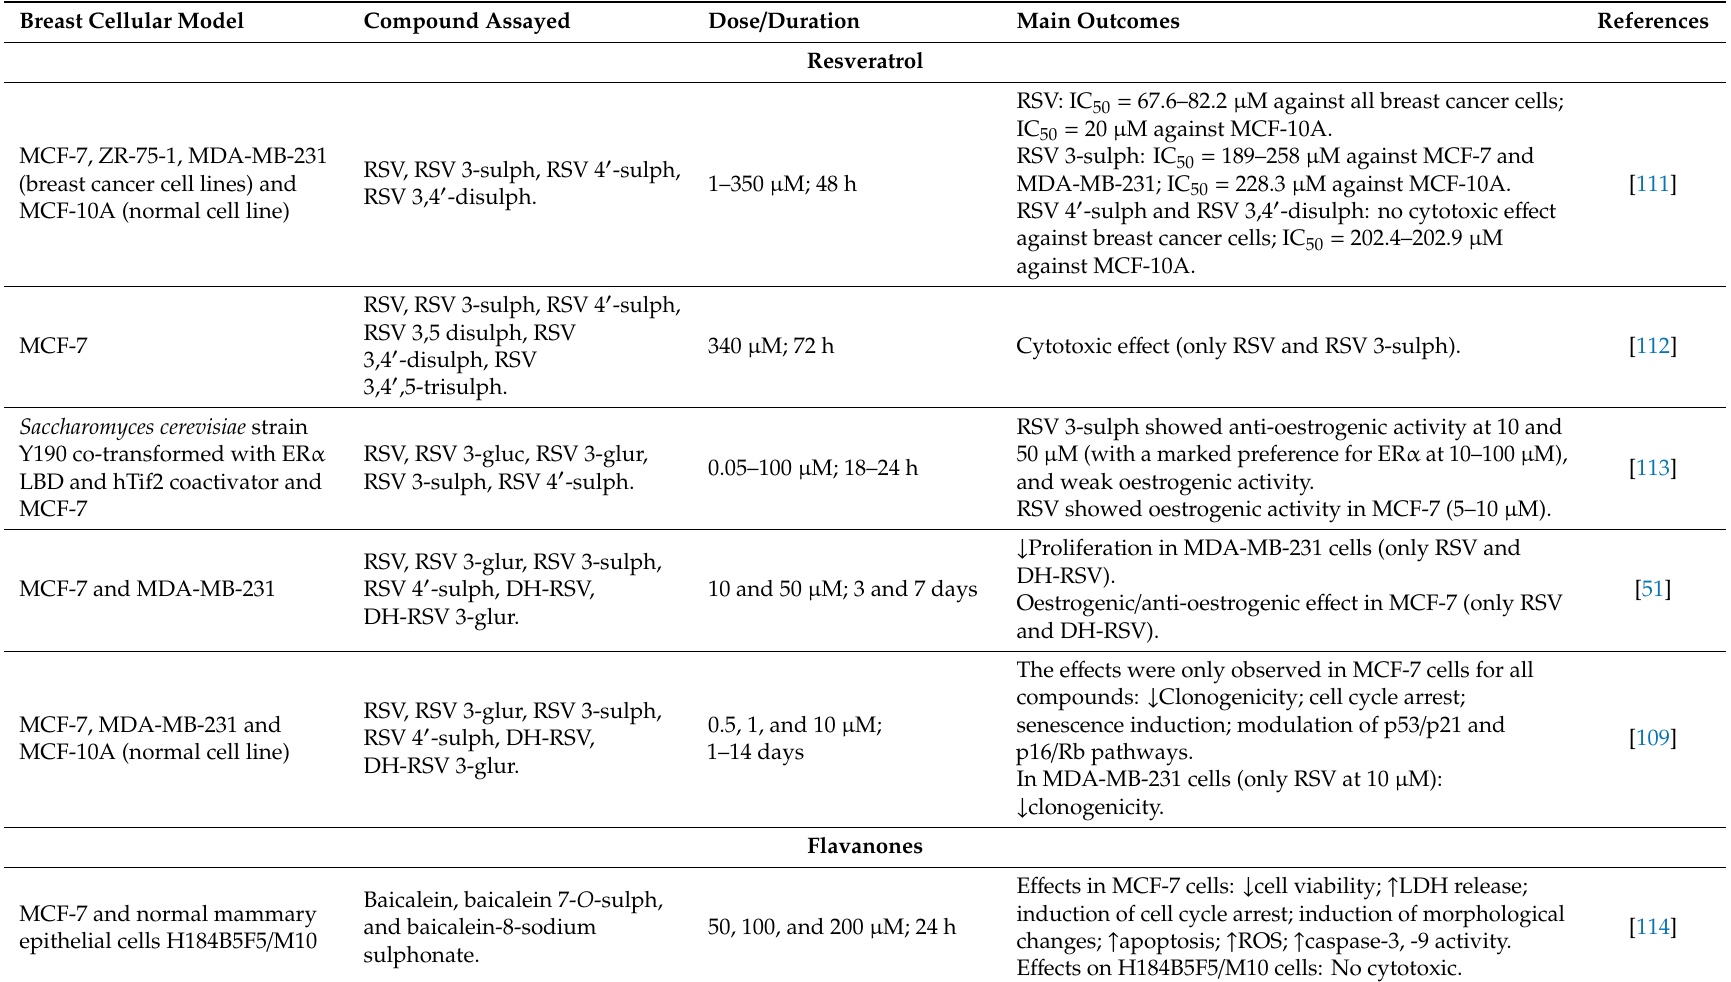
Table 2. In vitro studies conducted with relevant phenolic-derived metabolites on breast cancer (BC)